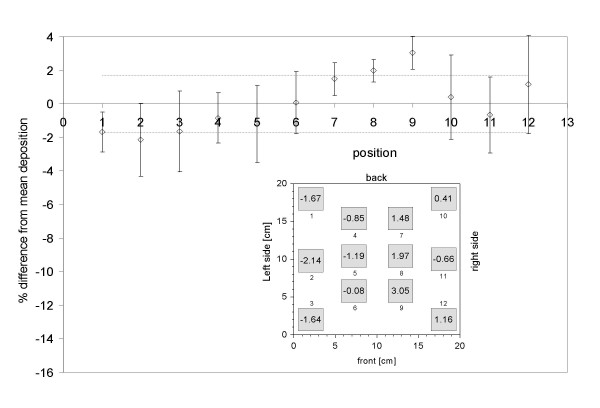
Spatial uniformity of droplet deposition. Measurement of (dry) NaCl mass (proportional to droplet mass) deposited on 12 aluminum foils (3 × 3 cm2) placed in the exposure chamber (see insert) after nebulization of 1 mL of a 10% NaCl solution in the ALICE. Droplets enter the chamber from the left and the droplet depleted air exits through the right hand side. The data are presented as relative difference from the mean deposited mass on each foil (n = 4) and the variability about the mean. The average of these mean values is 0% (per definition) and the variability of the mean values (spatial uniformity) is 1.6% (dashed lines). Since this is identical to the estimated measurement uncertainty, the data indicate uniform particle deposition across the exposure chamber.